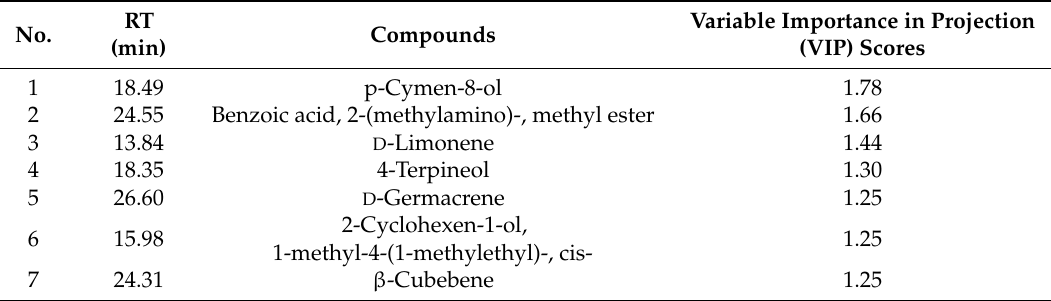
Table 3. List of potential chemical